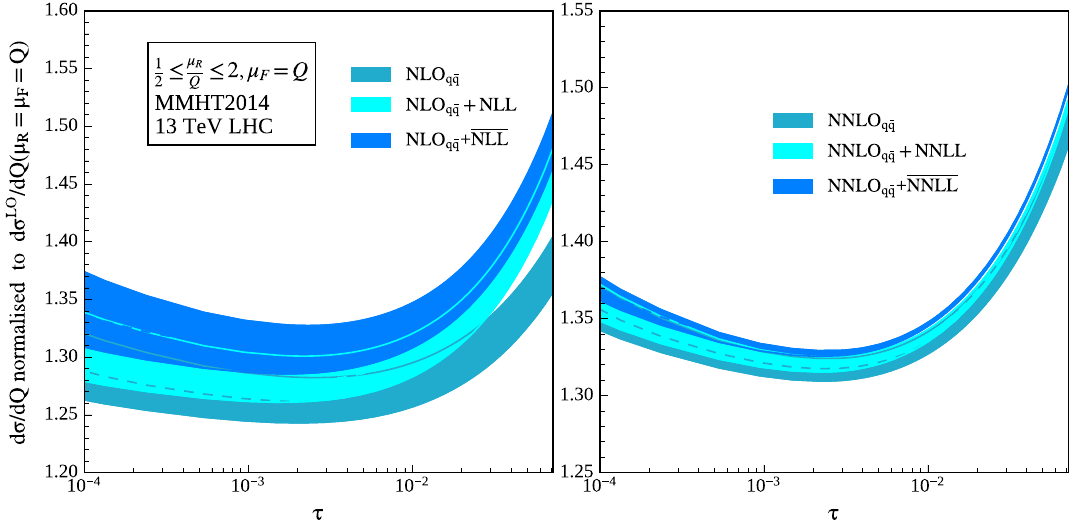
Fig. 12 μ R variation between SV and SV + NSV resummed results matched to NLO (left panel) and NNLO (right panel) with the scale μ F held fixed at Q